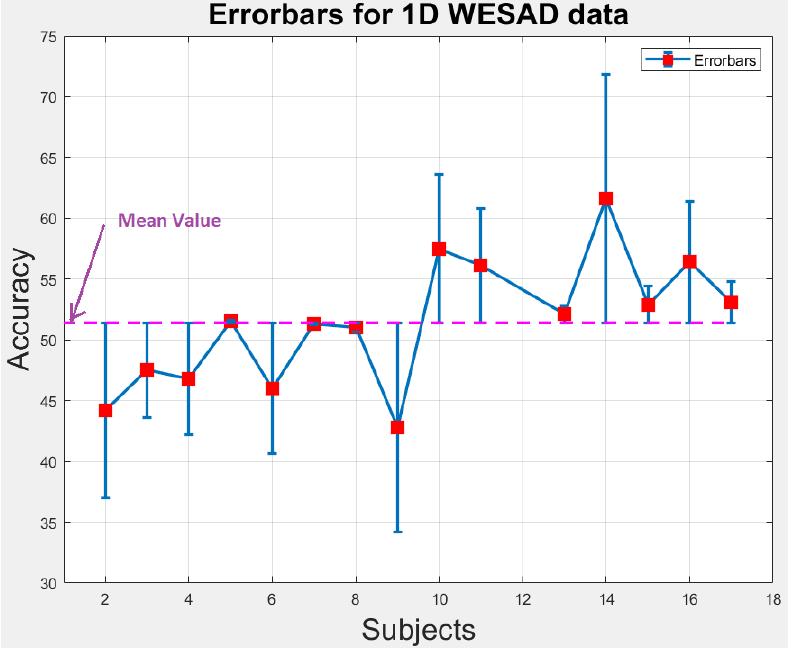
Figure 9. Error-bars showing inter-subject variability in terms of accuracy across the mean value for 1D WESAD data.